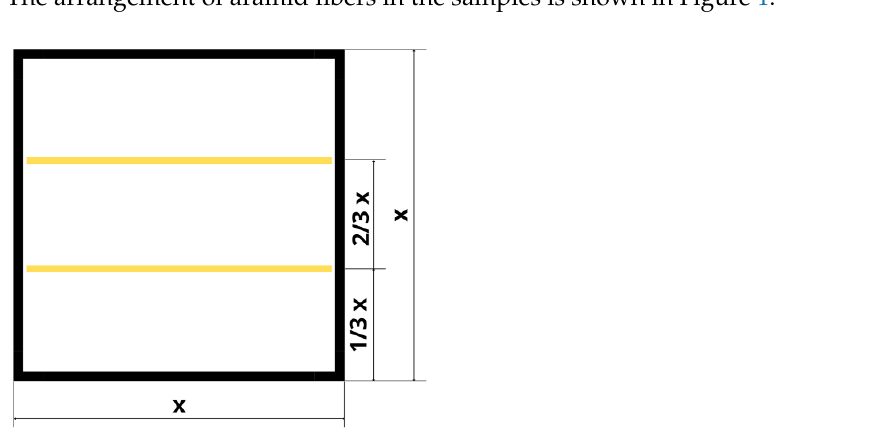
Figure 1. Aramid roving distribution in the sample. The figure concerns samples with dimensions of 50 × 50 × 50 mm and 100 × 100 × 100 mm, where x refers to 50 mm or 100 mm. By producing samples by casting, the prepared mixtures were poured into molds with dimensions of 50 mm × 50 mm × 50 mm for tests in a climatic chamber and for